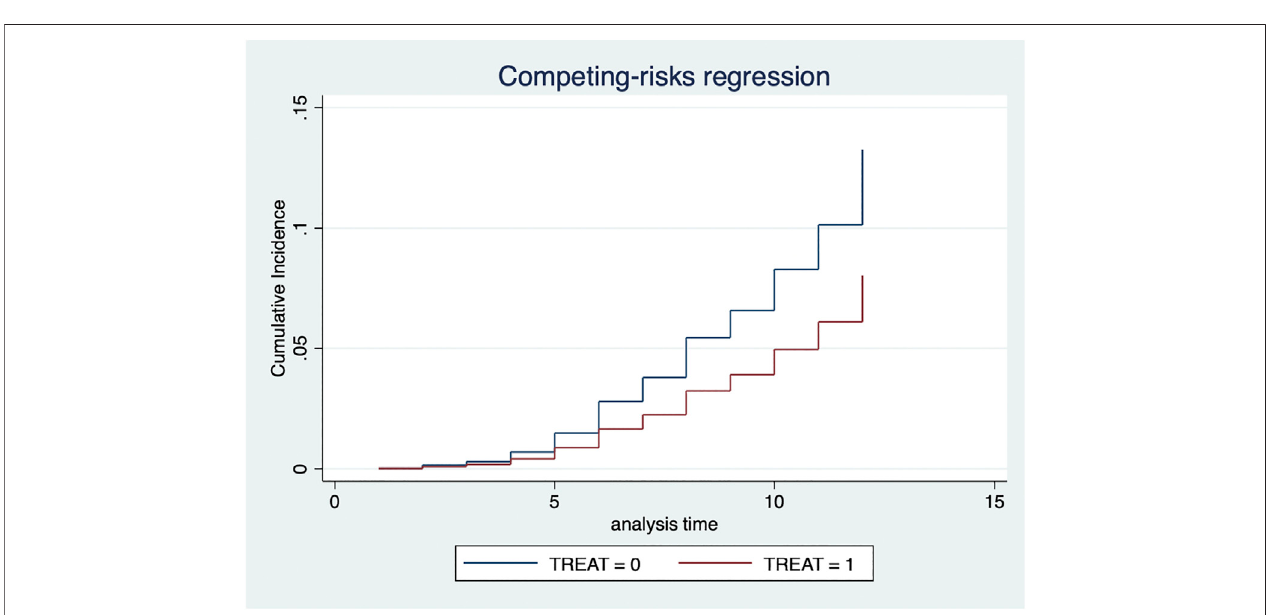
FIGURE 1 | Cumulative Incidence Functions Across Treatment and Control Groups. By Dina Ghazzawi, Donna Pattison, and Catherine Horn.